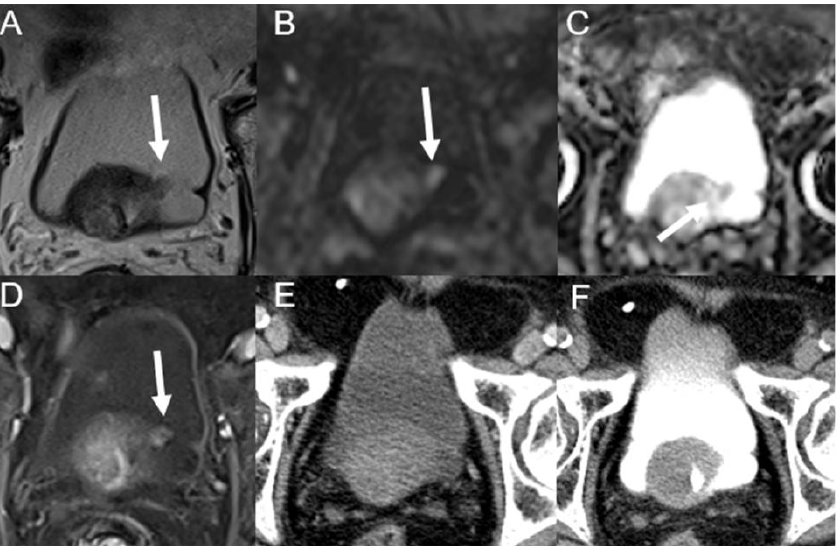
Table 4. MRI and MDCT diagnostic accuracy of different tumor morphologies in 56 patients with recurrent BC. Figure 4. An 86-year-old man underwent trans-urethral resection of BC 48 months ago. T2WI ( A ), DWI ( B ), apparent diffusion coefficient ( C ) and DCE ( D ) images show a papillary mass (arrow) with a diameter of 0.9 cm in the left posterior wall of the bladder. However, multidetector computed